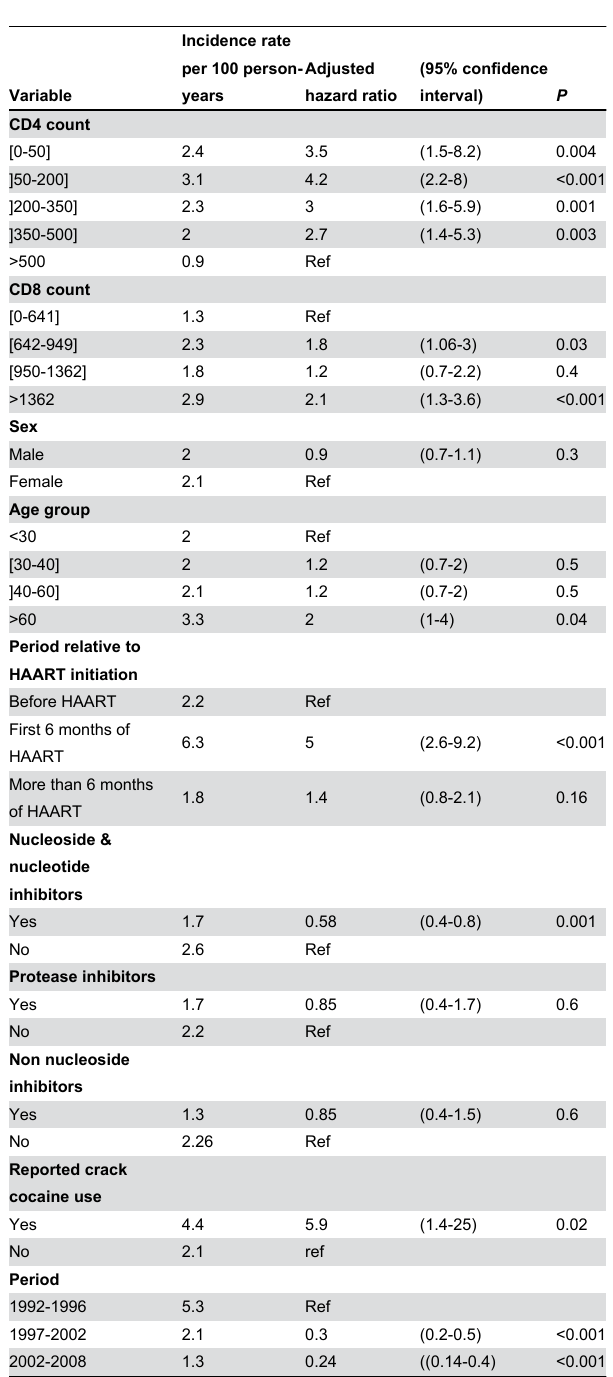
Table 2. Age-specific incidence rate of herpes zoster for crack users and non